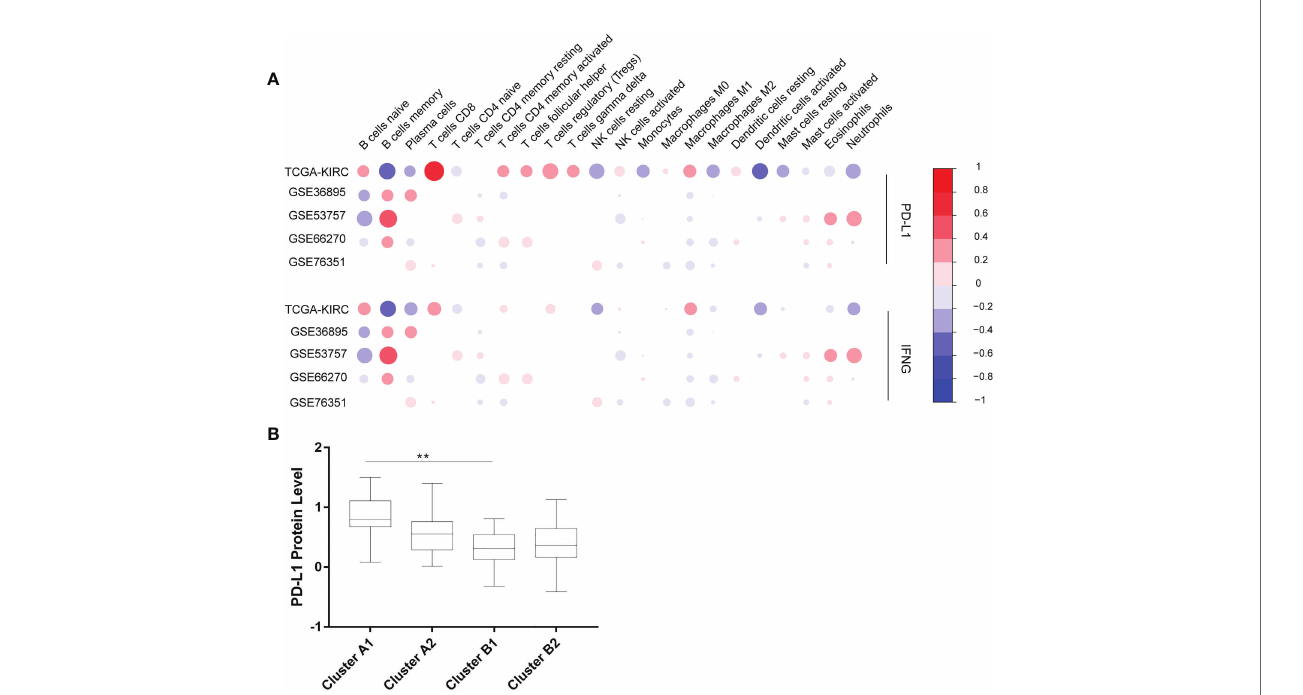
FIGURE 2 | (A) Correlation between 22 immune cells contents and expression levels of PD-L1 and IFN- g . The abscissa indicates 22 kinds immune cells while the ordinate represents 5 independent datasets of KIRC. Red means positively related; blue means negatively related; size of circles and shades of colors mean magnitude of correlation. (B) PD-L1 expression levels of 4 immune sub-clusters. **p <